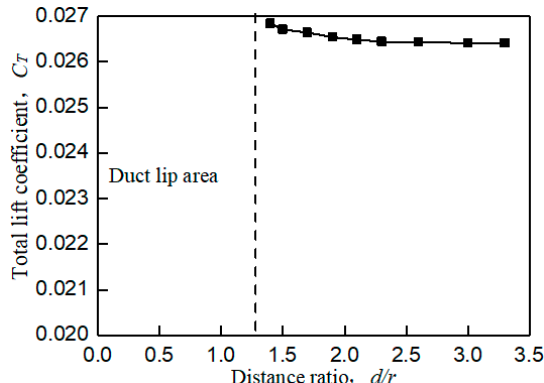
Figure 6. Connection diagram of total lift coefficient at different distance ratios (wall effect).